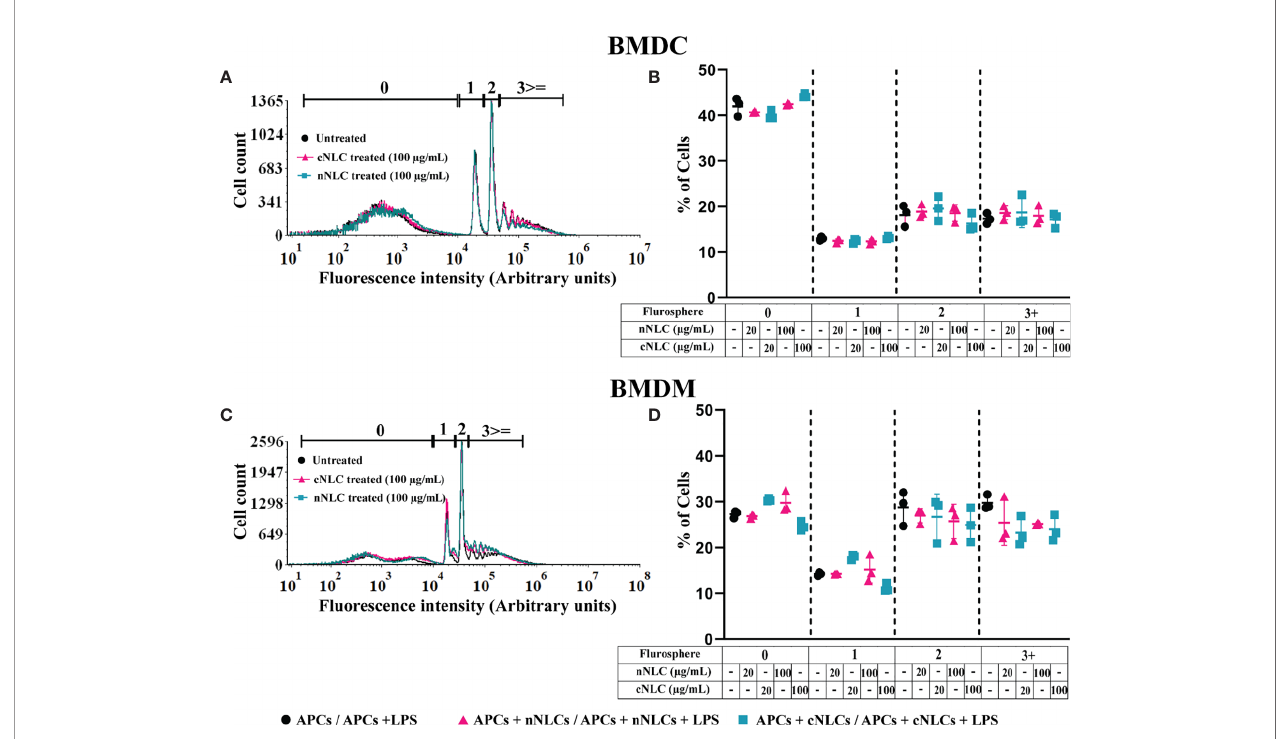
FIGURE 2 | Phagocytic capacity of APCs exposed to nNLCs or cNLCs. BMDCs and BMDMs were exposed to nNLCs and cNLCs nanocarriers at 20 and 100 µg/mL for 24 h, then incubated with fl uorescent microspheres for 6 h and subsequently analysed by fl ow cytometry. The repartition of the cells in the 1st, 2nd, 3rd and 4th peak corresponds to 0, 1, 2 and 3 or more beads internalisation, respectively. Overlaid histograms are shown in (A) for BMDCs and (C) for BMDMs. The proportion of cells in each peak was analysed for (B) BMDCs and (D) BMDMs. Data are displayed as mean ± SD (N = 3 independent